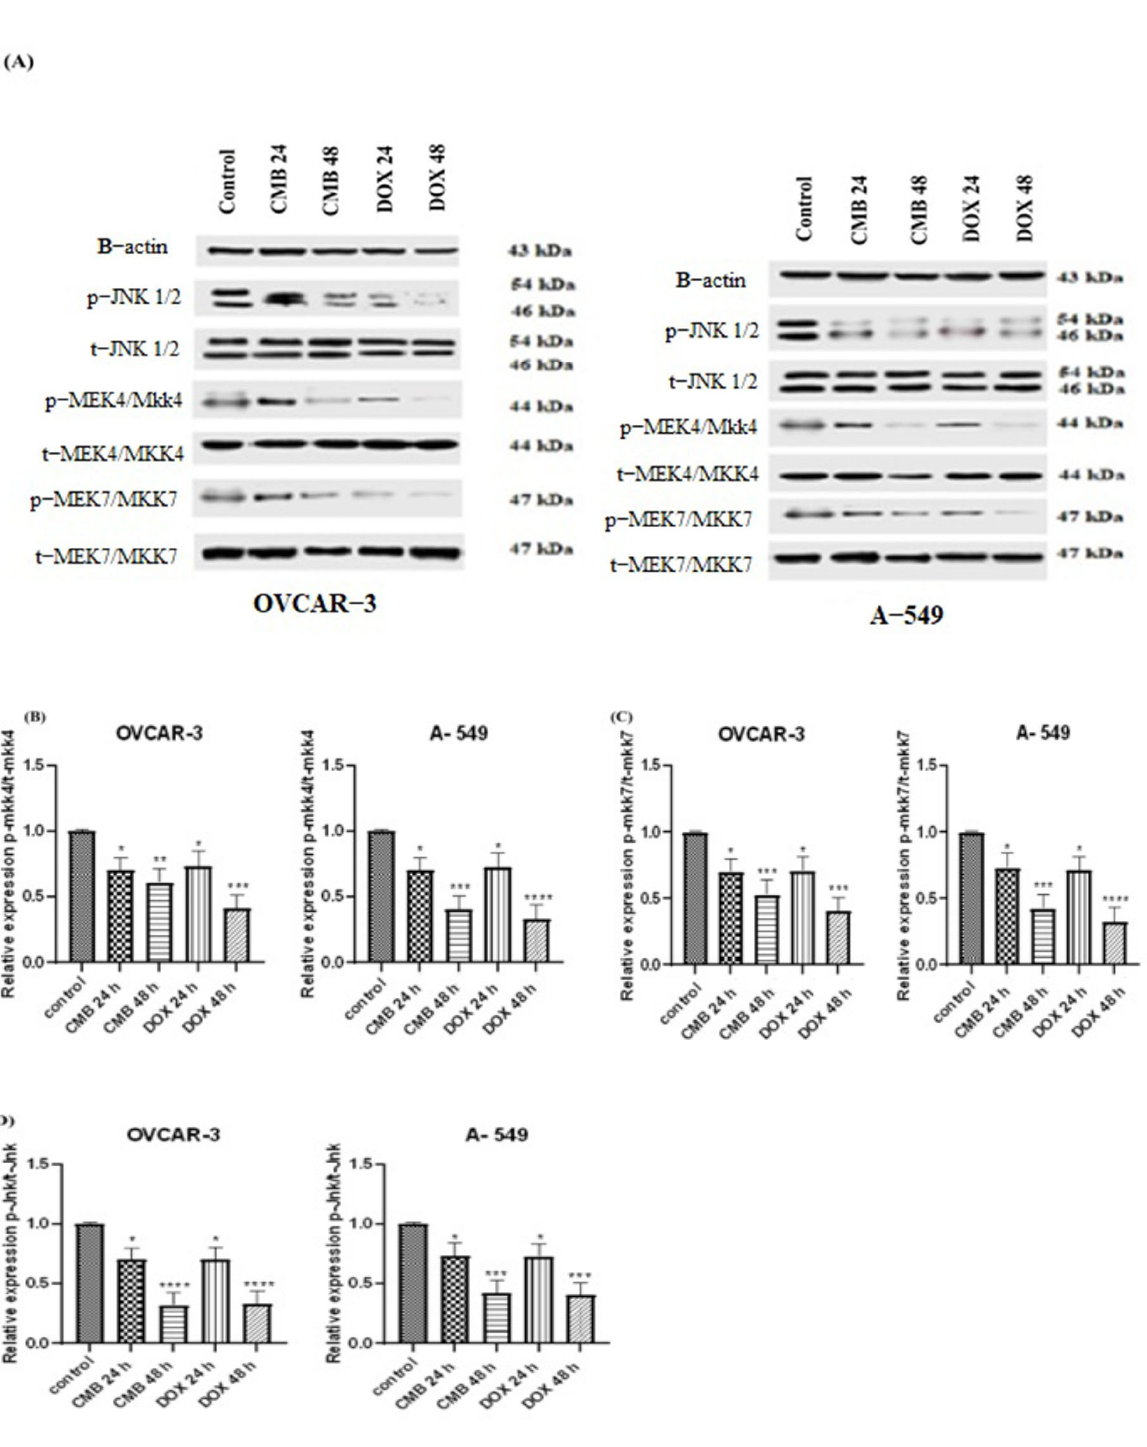
Figure 6. CMB suppresses the protein expression levels of p − mkk4, p − mkk7, and p − JKN1/2. ( A – D ) Western blot analysis of the protein levels of p − mkk4, p − mkk7, and p − JKN1/2 in OVCAR-3 and A-549 cells, respectively, incubated with CMB and doxorubicin at their IC 50 values for 24 h or 48 h. Means and SE were calculated from three independent experiments. Statistically significant results relative to untreated control were displayed as: * p < 0.05; ** p < 0.01; *** p < 0.001; **** p < 0.0001.